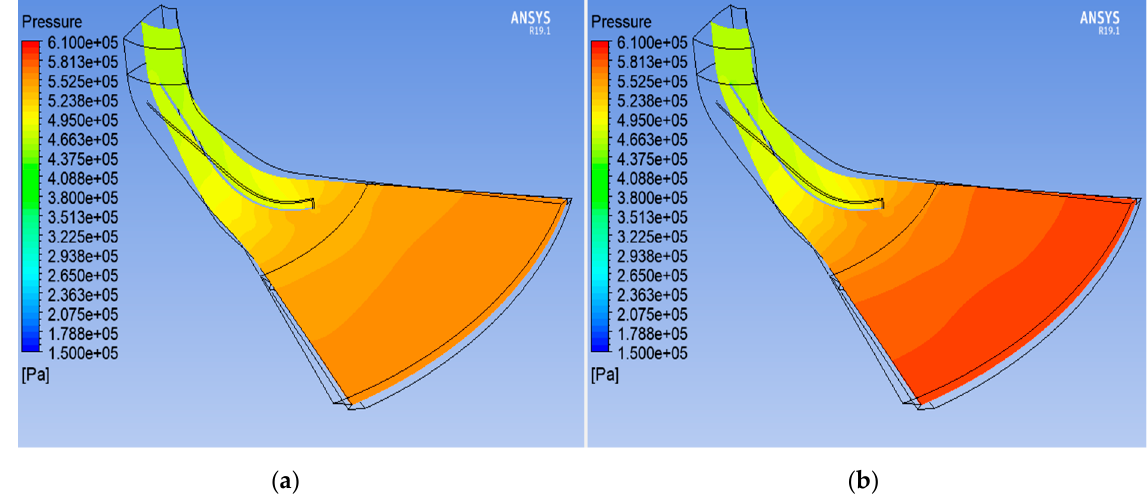
Figure 11. Pressure Contour for R290 at an RPM of 35,000 ( a ) and 40,000 ( b ).